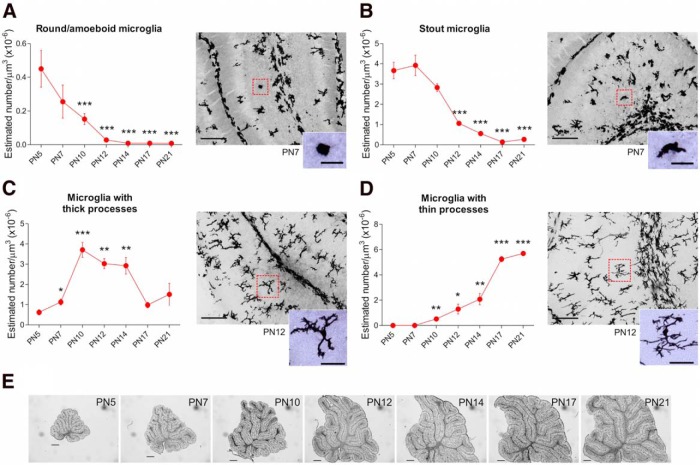
Morphological profile of microglia in the postnatal developing cerebellum. A, The frequency of round/amoeboid microglia significantly decreased after the first postnatal week (B), as well as stout microglia. C, Conversely, the density of microglia with thick processes increased only during the second postnatal week followed by a decrease in the third postnatal week. D, The density of microglia with thin processes gradually increased after the first postnatal week doubling their density by the third postnatal week. E, Sagittal views of the midvermis, labeled with Iba1, across the first 3 postnatal weeks. All data are expressed as mean ± SEM (n = 4, 2 males + 2 females for each group). Significant differences are detonated by *p < 0.05, **p < 0.01, and ***p < 0.000 compared with P5. Insets depict a higher magnification of selected microglia (red squares) in each panel. Scale bars: gray scale images, 100 µm; color images (inset), 25 µm; E, 500 µm (from P5 to P21). Images in A, B, C, and D depict the morphology of microglia at two different postnatal ages: P7 (A, B) and P12 (C, D).